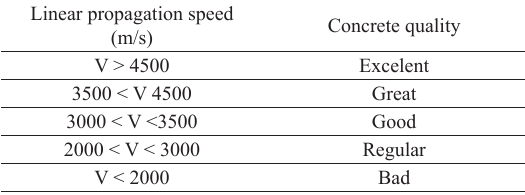
Figure 1. Fiber micrograph showing (a) frontal view of the epidermis of the fiber and (b) parenchymal region containing sclereids and parenchymal cells with lignified thickening bars.